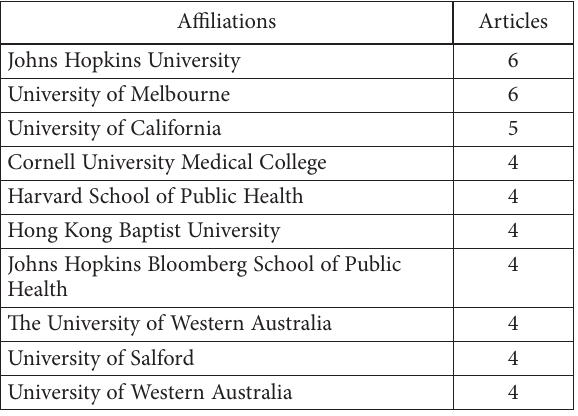
Table 6. Most influential organizations in the field of AI in PM